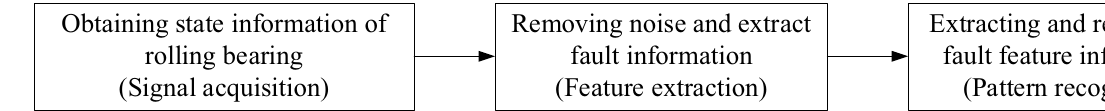
Fig. 1 Bearing fault diagnosis